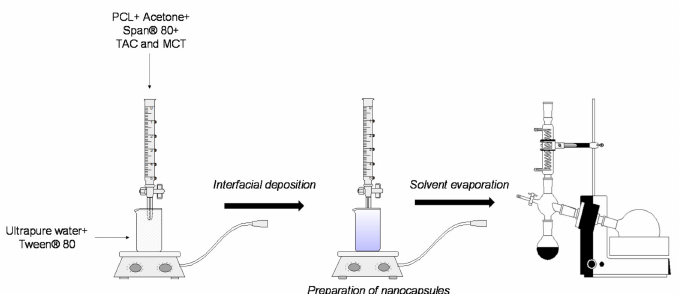
Figure 1. Scheme of the obtaining method of TAC-loaded PCL nanocapsules by interfacial deposition of preformed